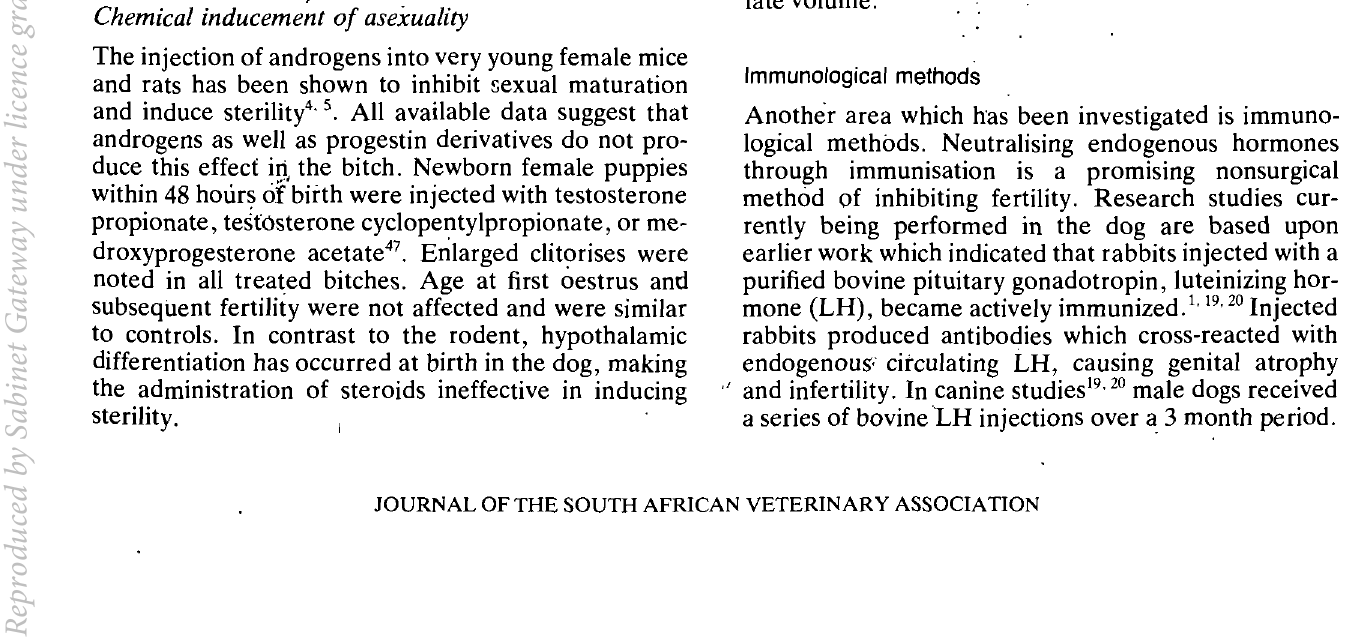
Table 2: BIOLOGICAL EFFECTS THAT HAVE BEEN ASSOCIATED WITH THE USE OF PROGESTATIONAL STEROIDS IN THE BITCH 35 Oestrous Inhibition Oestrous